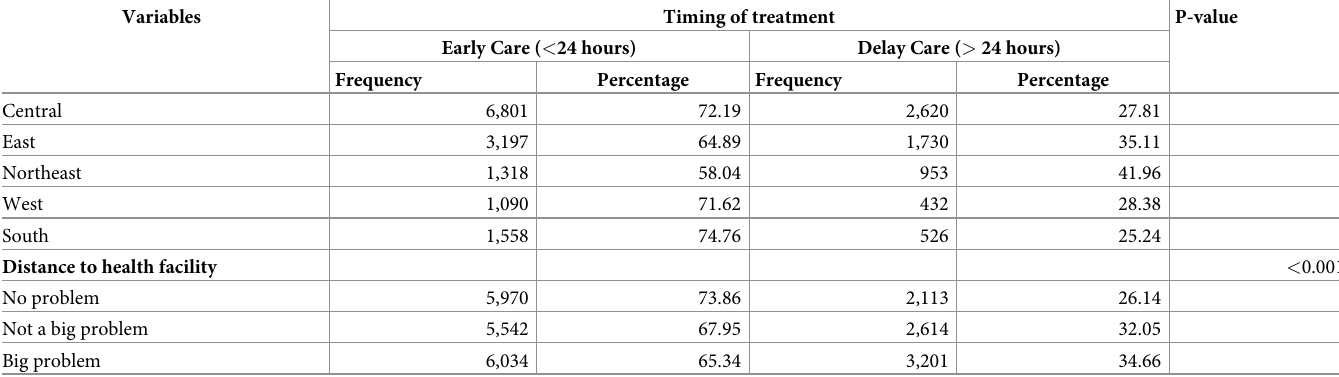
Table 2 illustrates the results of univariate and multivariate logistic regression models to exam- ine the factors associated with delay in treatment-seeking behavior for under-five children among caregivers in India. The unadjusted analysis revealed that children living in rural areas were associated with higher odds of delay in treatment-seeking (Unadjusted OR: 1.51, 95% CI: 1.42–1.61) compared to those living in urban areas. Children of mothers in the age range of 25–34 years (Unadjusted OR: 0.88, 95% CI: 0.80–0.96) were less likely to delay the treatment than those children of mothers aged 34–49 years. Children in the poorest wealth quintile were 2.4 times more likely to be treated after 24 hours of the onset of fever as compared to those children in the richest wealth quintile. Delay in seeking treatment was found to be significantly higher among the children who belonged to the Scheduled tribe (Unadjusted OR: 1.61, 95% CI: 1.47–1.76) than those from Scheduled caste. Christian children were 34% more likely to seek treatment after 24 hours. Caregivers had a reduced chance of 32% (Unadjusted OR: 0.68, 95% CI: 0.61–0.76) of seeking delay treatment if they took a child to a community centre com- pared to a public health facilities. Similarly, caregivers of the children who resided in the North-East (Unadjusted OR: 1.55, 95% CI: 1.40–1.72) and East region (Unadjusted OR: 1.16, 95% CI: 1.07–1.26) were more likely to delay in seeking treatment than those living in the north region of the country. 0.82, 95% CI: 0.75–0.90), compared to the children aged 49–60 months. Children residing in 1.07–1.22) than the urban counterparts. Children from the poorest wealth quintile were more likely to have delayed treatment (Adjusted OR: 2.06, 95% CI: 1.85–2.31) compared to the chil- dren from the richest wealth quintile. The likelihood of delay in treatment-seeking was 35% higher among the Scheduled tribe (Adjusted OR: 1.35, 95% CI: 1.24–1.48) as compared to the Scheduled Caste. Muslim children had 9% reduced odds of having a delay in treatment-seek- ing (Adjusted OR: 0.92, 95% CI: 0.85–0.98) as compared with the children belonging to the Hindu religion. Children from the northeast region were more likely (Adjusted OR: 1.29, 95% CI: 1.14–1.46) to delay the treatment than children from the country’s north region. But the children from the south (Adjusted OR: 0.73, 95% CI: 0.66–0.80) and central region (Adjusted OR: 0.73, 95% CI: 0.68–0.78) were less likely to delay the treatment as compared to